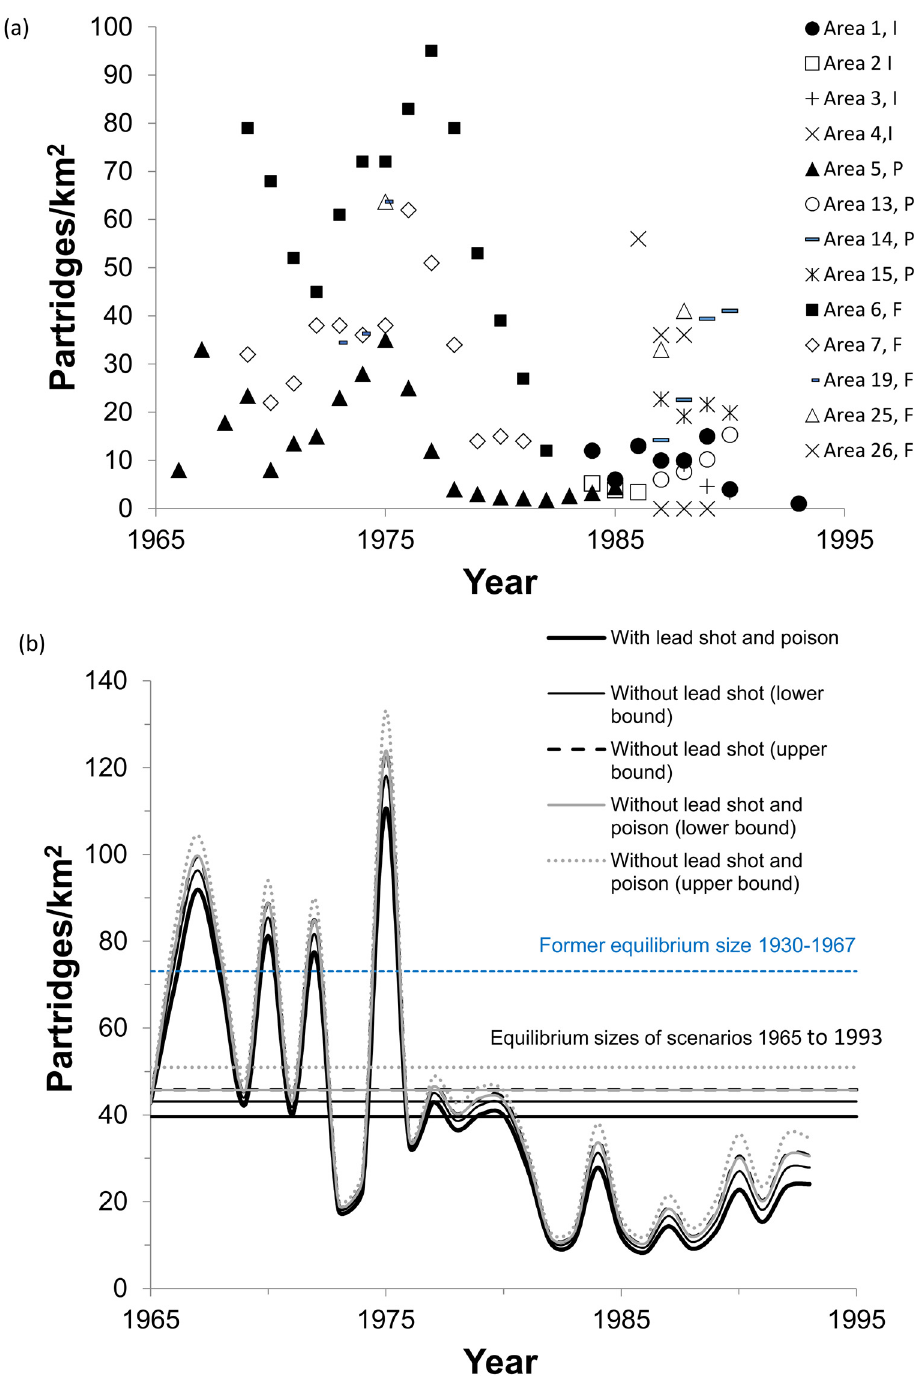
Fig 4. Grey partridge observed and modeled population trends. (a) Observed declining grey partridge population trends shown in different areas of continental Europe (I = Italy, P = Poland, F = France [10]). (b) One modeled declining partridge trajectory shown for four scenarios of the population in continental Europe fluctuating around the steady-state equilibrium population size (horizontal line) with and without ingestion of lead shot and pesticide poisons. Lower and upper bounds represent removal of ingestion of lead shot causing 4 and 7% of the mortality, respectively. Shown for comparison is the estimated higher equilibrium size (in blue) during the early 20 th century (based on UK data